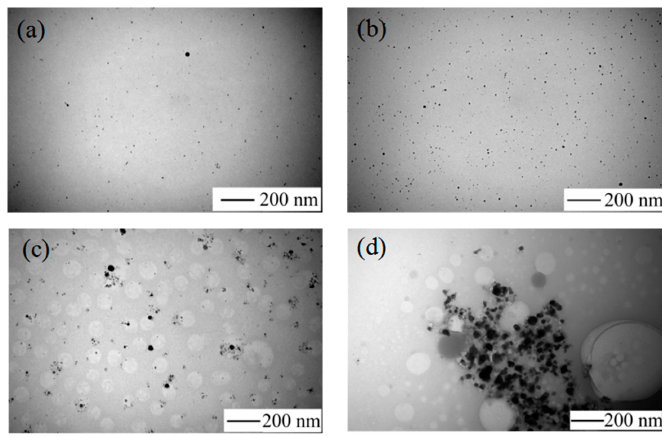
Figure 4. TEM images of the preparation of Ag nanoparticles. ( a ) 2 min; ( b ) 5 min; ( c ) 12 min; and ( d ) 20 min.